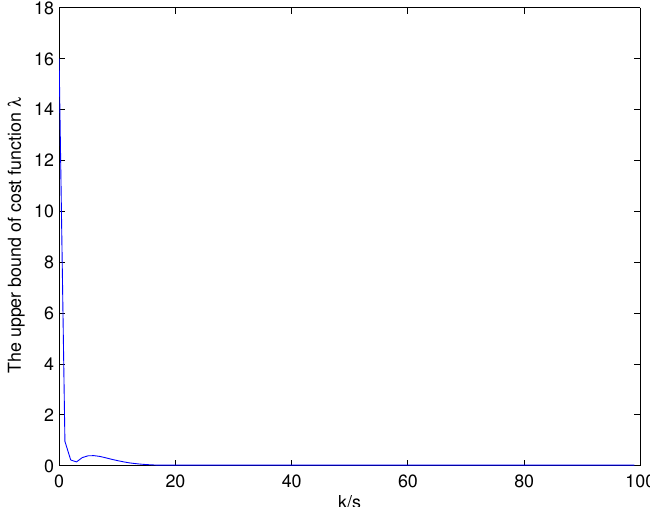
Figure 11. The control law for the proposed method and OFRMPC method.